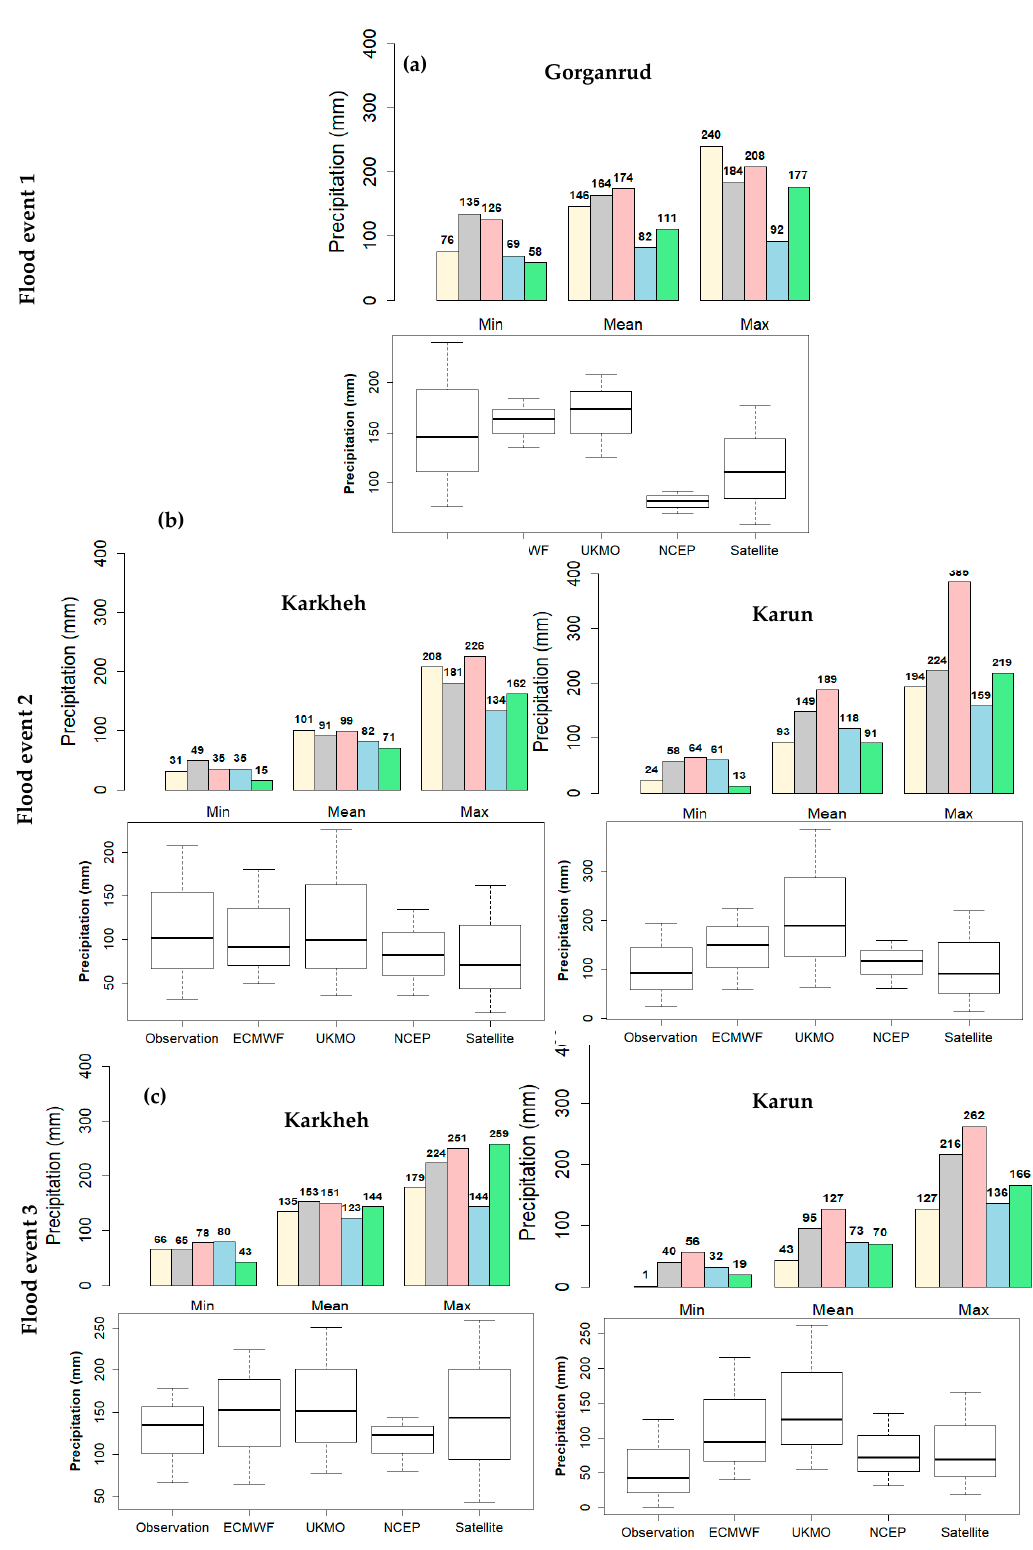
Figure 7. Mean, maximum, minimum precipitation amounts and box-plots in the ( a ) Gorganrud, Karkheh, and Karun Basins for the a) first, ( b ) second, and ( c ) third flood events. The center-line of each boxplot depicts the median value (50th percentile) and the box encompasses the 25th and 75th percentiles of the sample data, while the whiskers represent the extreme values,